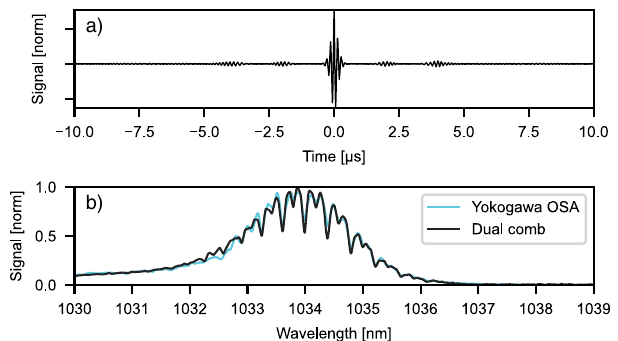
Fig. 8 Acetylene spectroscopy. a A 20 µ s time trace with main interferogram and decay oscillations induced by acetylene is shown. b Spectra of a single interferogram (black) and reference spectrum (turquoise, Yokogawa OSA) are